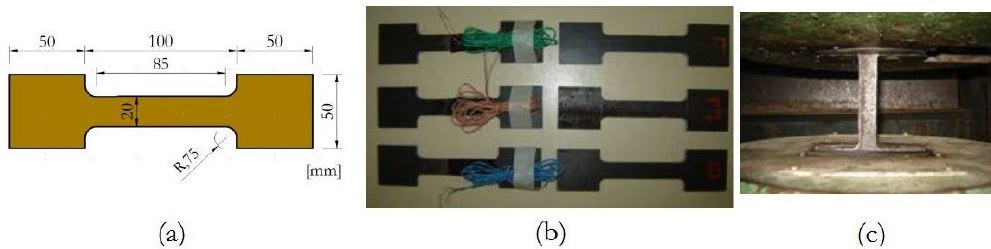
Figure 2. Steel specimen: (a) dimensions; (b) specimen; (c) on the testing